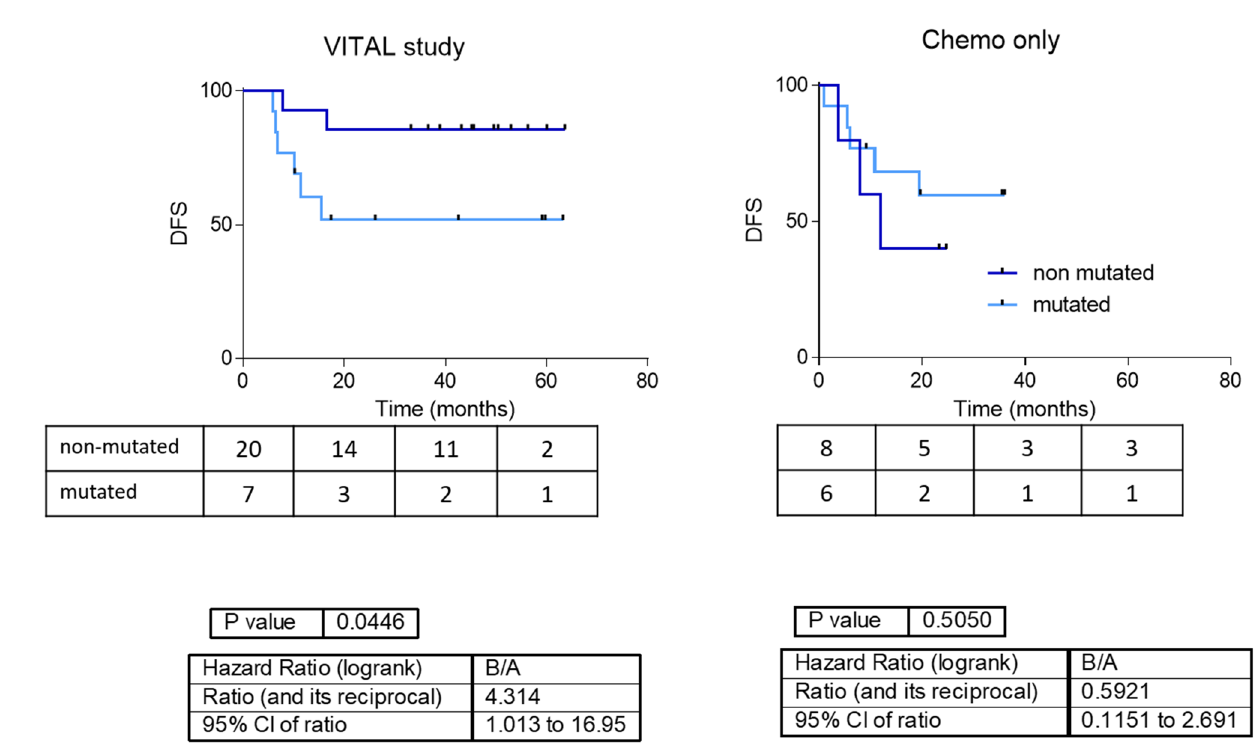
Figure 3. Survival curves according mutation accumulation in pharmacodynamics pathway of EGFR inhibitors. Survival curves grouping patients from the VITAL clinical trial and from the chemoradiotherapy cohort according to the presence of high- and moderate-impact genetic variants in genes involved in the pharmacodynamics pathway of EGFR